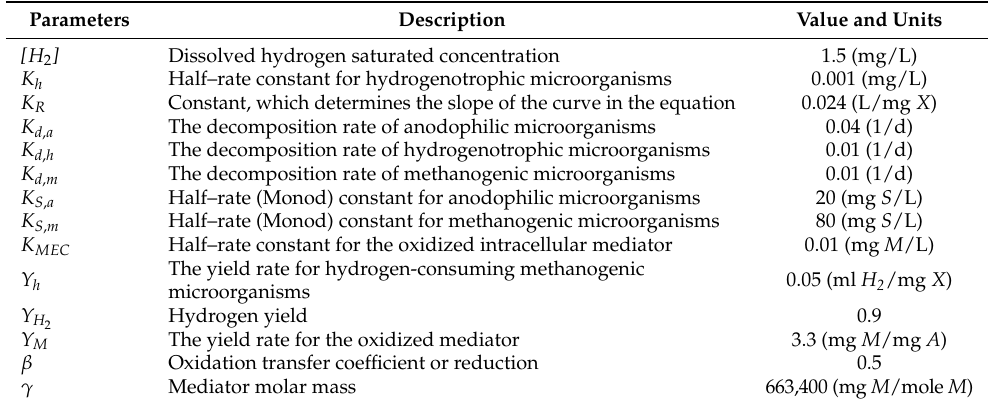
Table 1. Modeling parameters for two types of